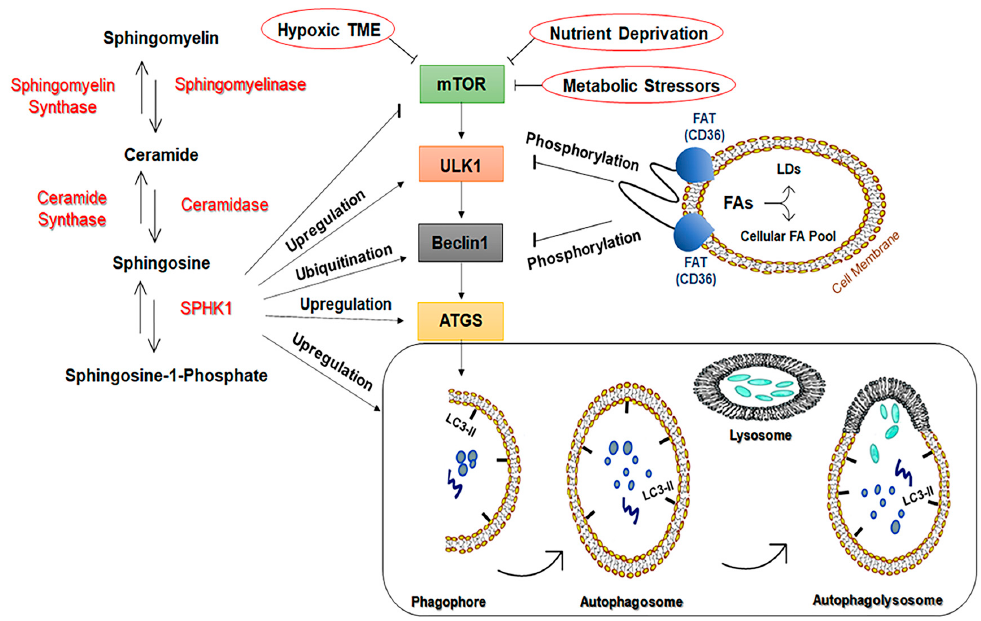
Figure 7. SPHK1 and FAT can regulate autophagy during cancer. A simplified scheme of sphingolipid metabolism and turnover is also shown.